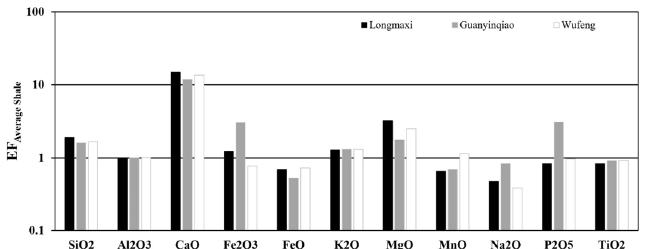
Figure 5. Enrichment factors of the major elements from the Wufeng-Longmaxi formations in the Xindi No. 2 well. The horizontal line is the EF of average shale, which is equal to 1 to highlight the enrichment or depletion of